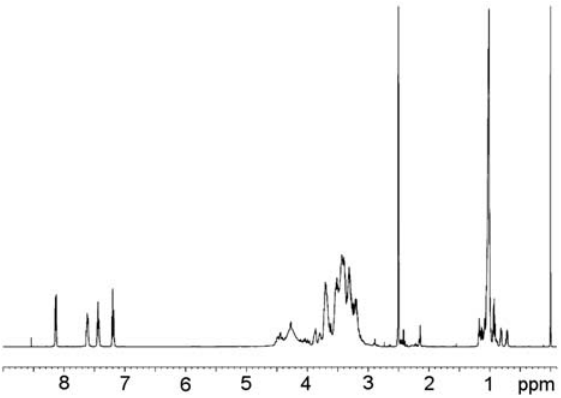
Fig. 5. 1 H-NMR spectrum of oligoetherol obtained from the C : GL :EO:PO = 1 : 7 : 4 : 6 molar ratio system